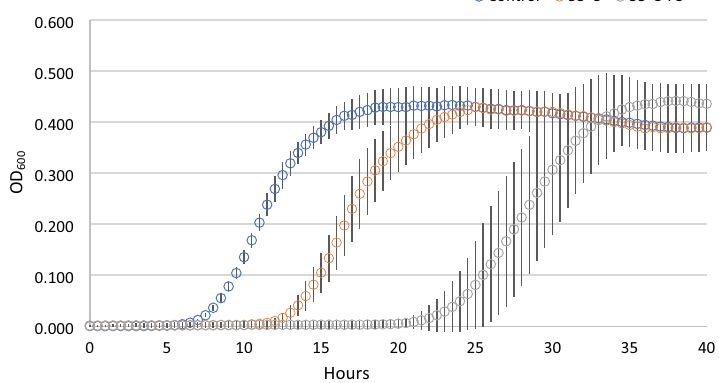
Figure 2. Growth curves of cells derived from condition 1, after antimicrobial treatments. Each time point is the mean of 28 replicates. For each point standard deviation is